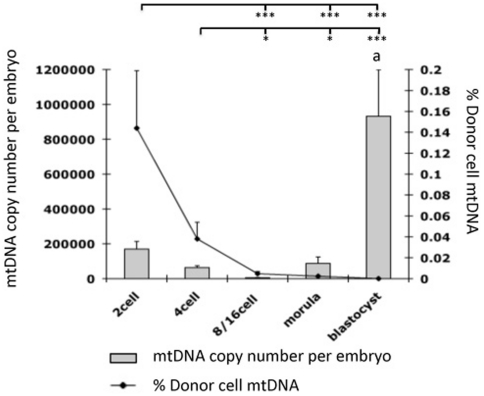
Analysis of total mtDNA copy number and donor cell contribution throughout preimplantation development of murine-porcine embryos.Superscript a indicates a significant difference of P<0.001 with all other stages of development. Mean (±SEM) donor cell mtDNA content, as assessed by AS-PCR, is expressed as a percentage of total donor cell mtDNA. P<0.05 is denoted by *; P<0.01 by **; P<0.001 by ***.